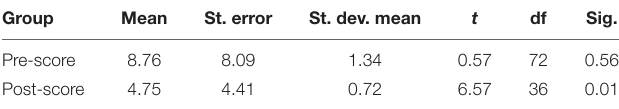
TABLE 6 | Pair sample test (experimental class).